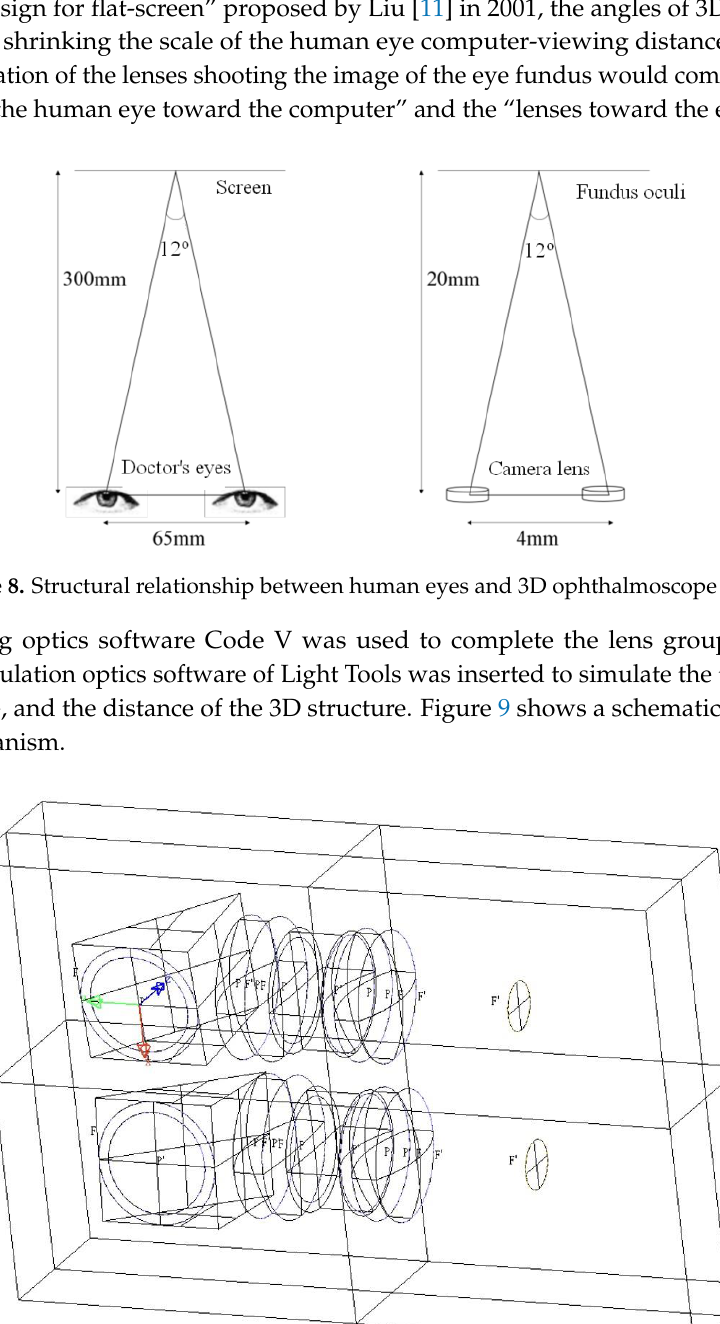
Figure 9. Schematic of the 3D optical mechanism.